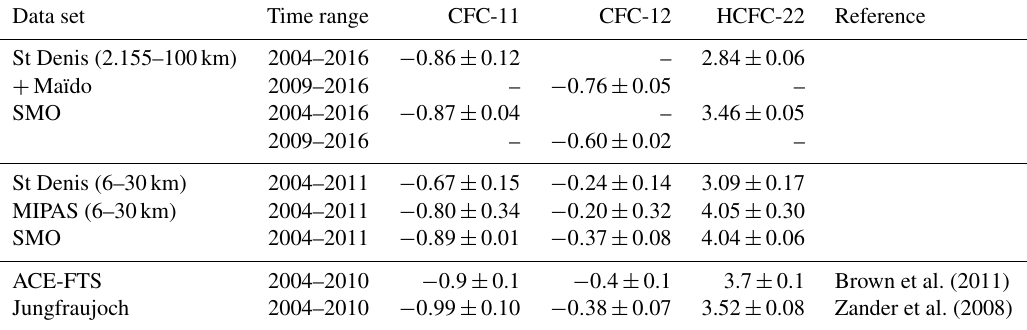
Table 5. The annual percent changes (in % year − 1 , relative to the mean of data used in the trend analysis) and uncertainties of FTIR total columns of CFC-11, CFC-12 and HCF-22 at St Denis (2004–2011) and of the combined partial columns (2.155–100km) at St Denis along with the total columns at Maïdo (2004–2016 for CFC-11 and HCFC-22; 2009–2016 for CFC-12). The trends from in situ and flask measurements at SMO are also given for the same time periods. The trends from St Denis partial column (6–30km) and MIPAS partial column (6–30km) from 2004 to 2011 are also listed in the table. The trends observed by ACE-FTS (2004–2010) and by the ground-based FTIR at Jungfraujoch (2004–2010) in % year − 1 relative to the 2007 annual mean are taken from Carpenter et al. (2014) as described in the